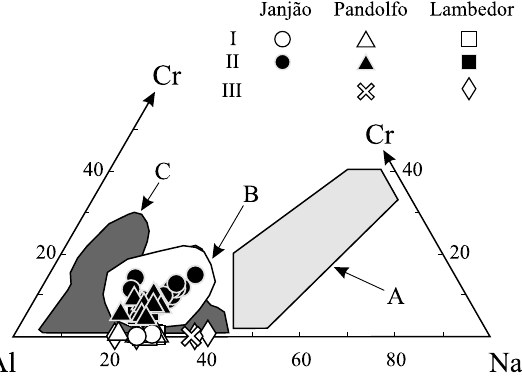
Fig. 9 – Al-Cr-Na ternary diagram for clinopyroxenes from the Janjão, PandolfoandLambedordiatremes. A)mantle-equilibratedclinopyrox- enes derived from kimberlite; B) clinopyroxenes from non-kimberlitic sources; C) clinopyroxenes equilibrated under crustal conditions (after Morris et al. 2002,